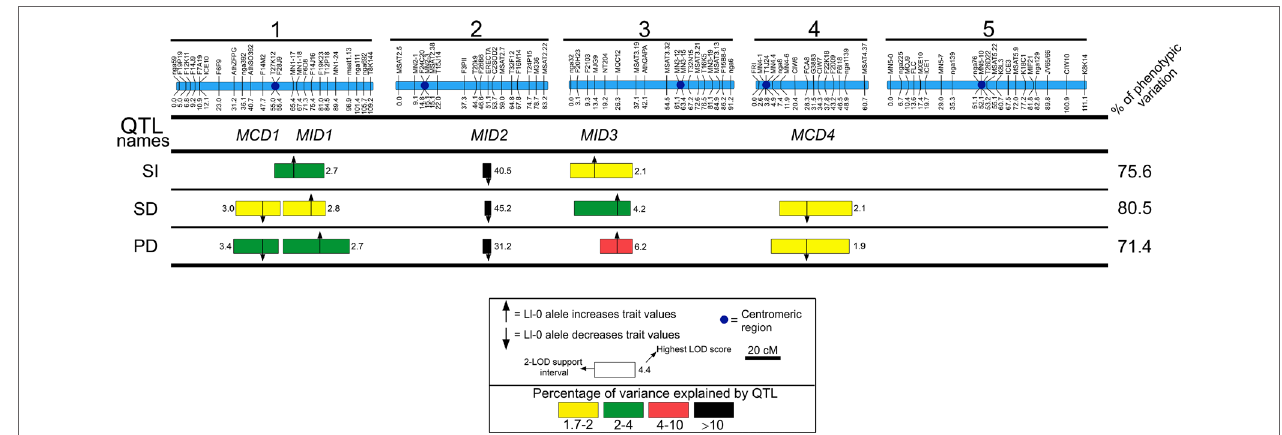
FIGURe 3 | QTL mapping of stomatal abundance traits in the L er /Ll-0 RIL population. Blue bars on the top represent the genetic maps of the five chromosomes, whereas QTL names are shown below: MID, Modulator of Cell Index and Density; MDC , Modulator of Cell Density . Horizontal lines separate traits analyzed: stomatal index (SI), stomatal density (SD), and pavement cell density (PD). Numbers in the right side show the percentage of phenotypic variance explained by the additive effects of all detected QTL. For each trait, the locations of QTL identified are shown as 2-LOD support intervals. Position of arrows and numbers inside boxes correspond to the highest LOD scores. Colors of QTL boxes depict the different ranges of QTL-explained variances as described in the inset. Arrows indicate that the additive effect of Ll-0 alleles increase (pointing up) or decrease (pointing down) the trait values in comparison with L er alleles.